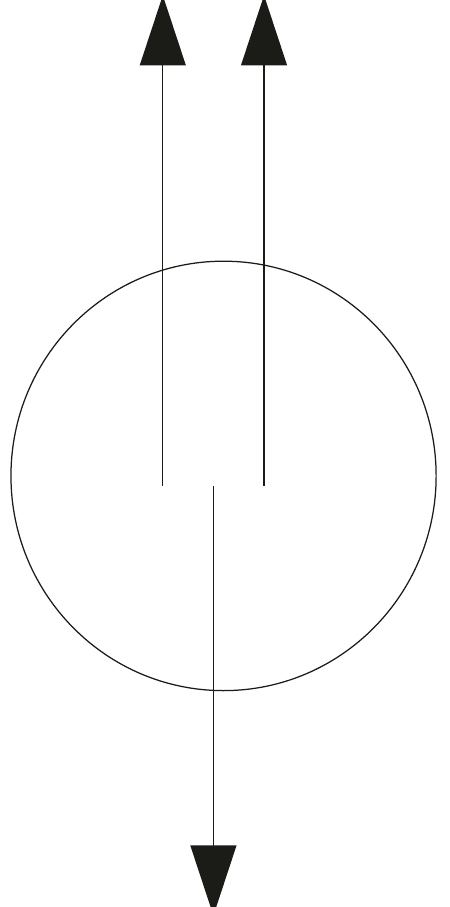
Figure 9: Schematic diagram of heterogeneous